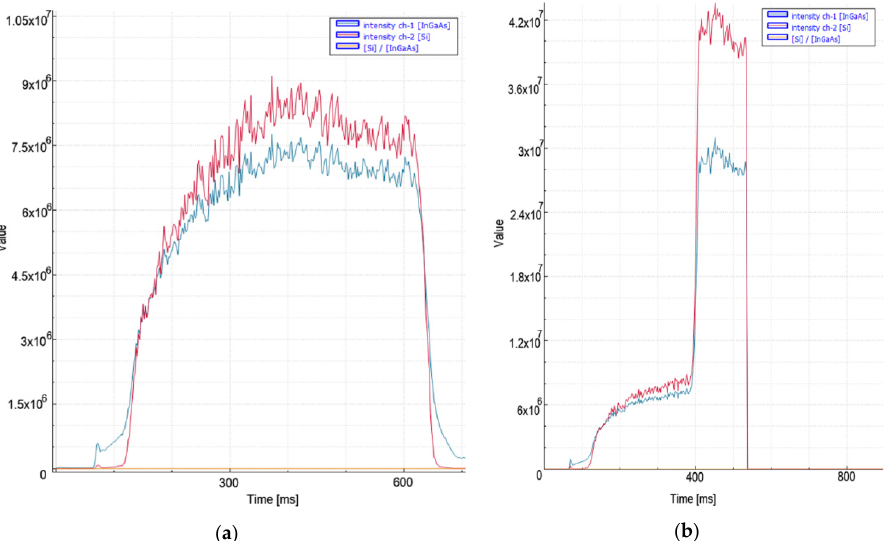
Figure 12. Measurement values recorded during nitrogen cutting of 4 mm mild steel material: ( a ) quality cut with ideal parameters, ( b ) the moment of deterioration of cut and quality.